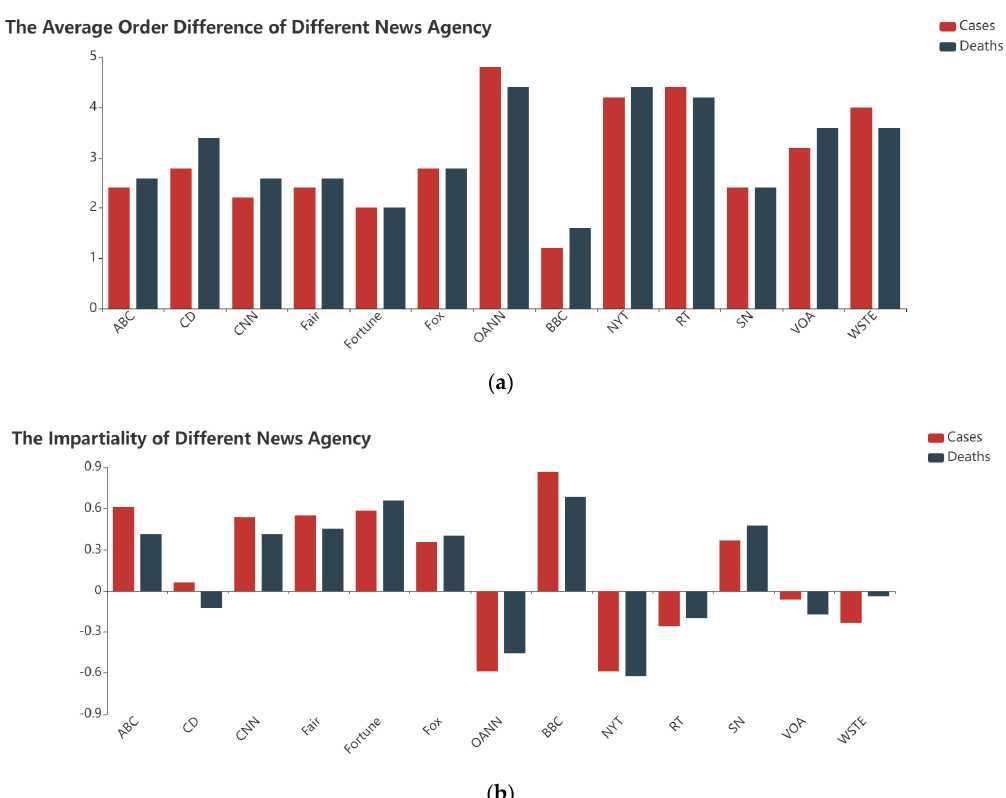
Figure 4. ( a ) The average ranking difference of different news agencies; ( b ) The impartiality of different news agencies.